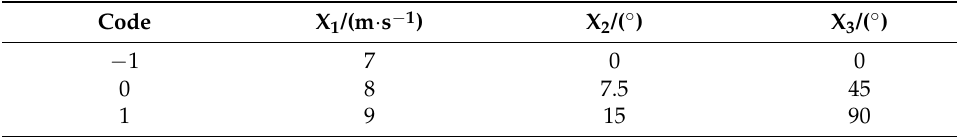
Table 4. Factors and levels of tests.